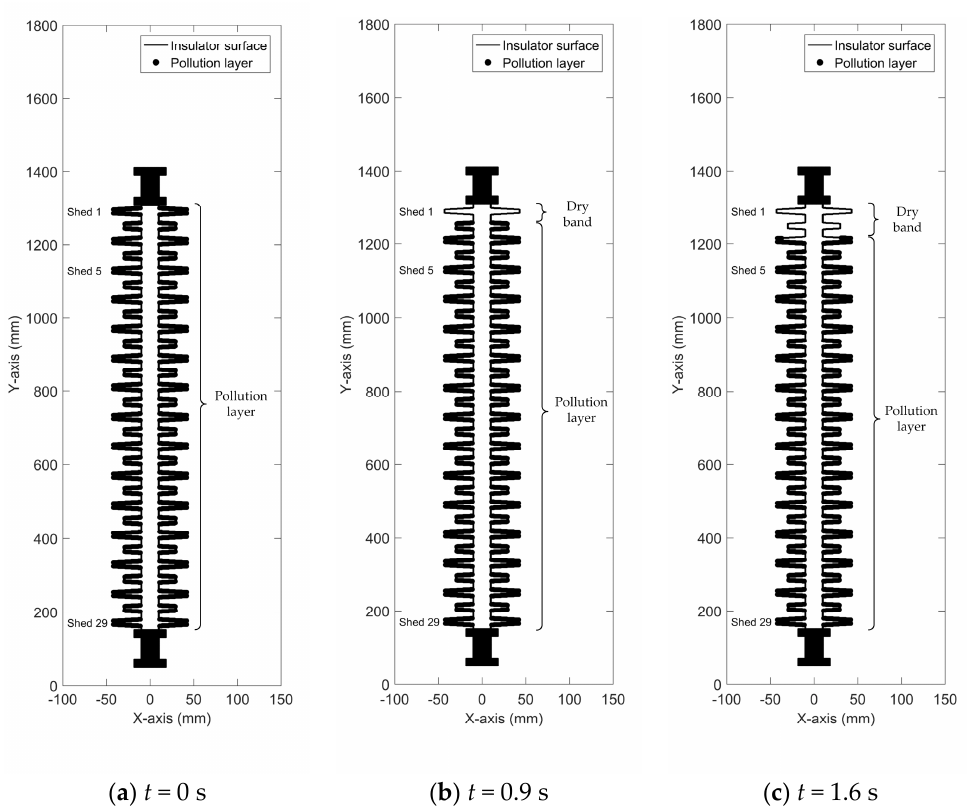
Figure 3. Dry band formation process on the insulator surface at different time nodes.